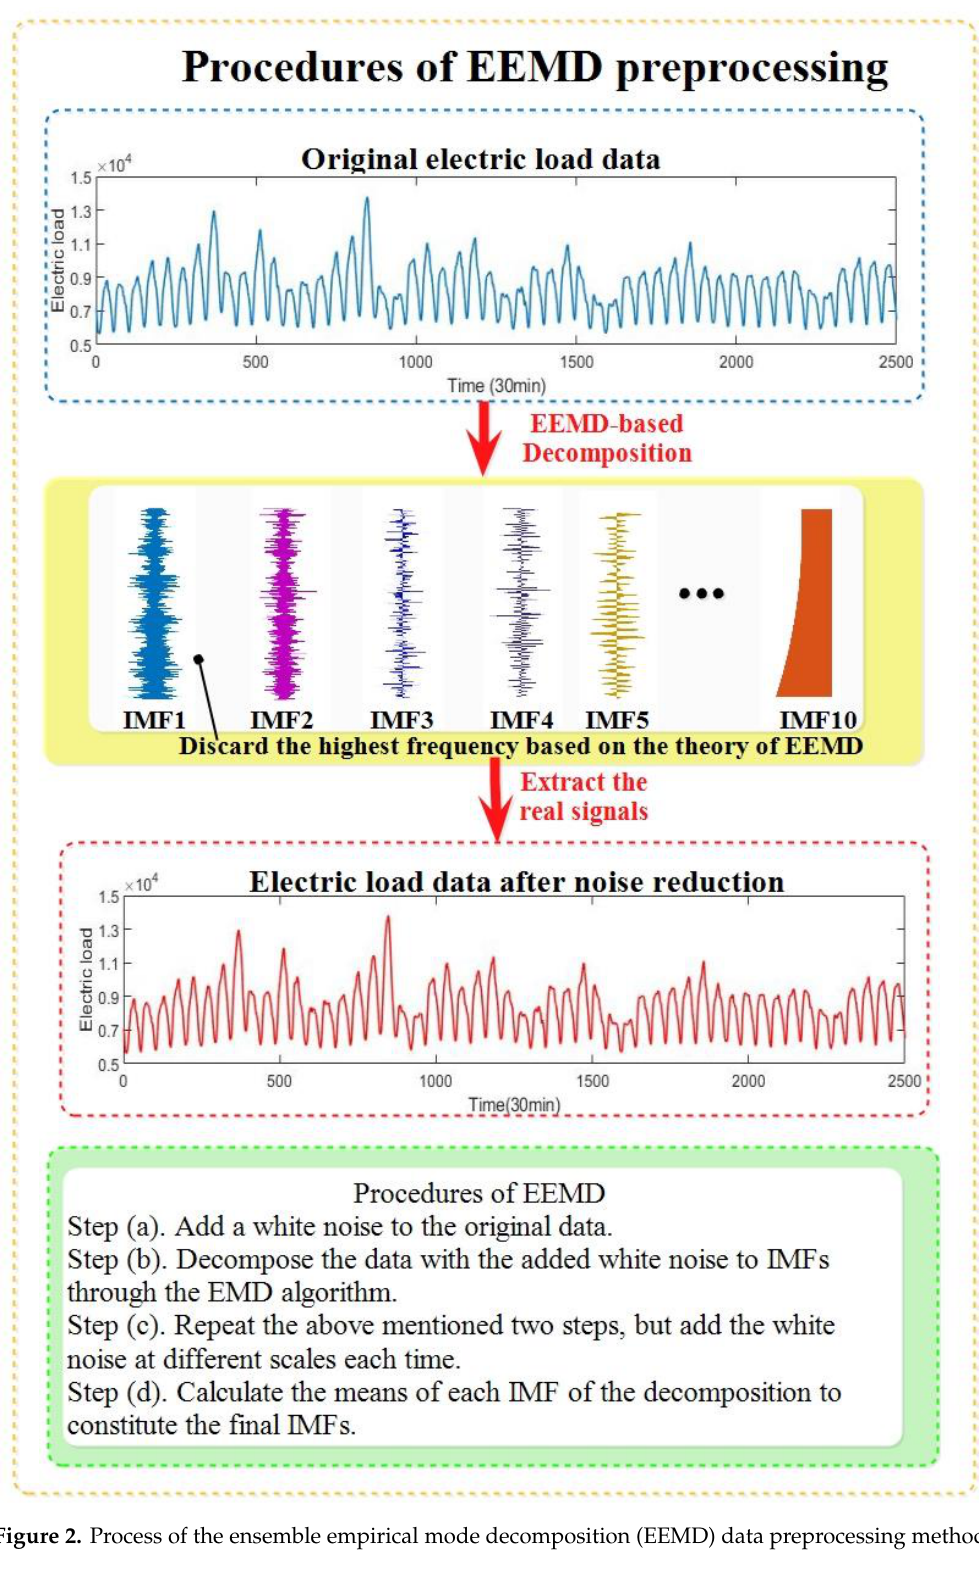
Figure 2. Process of the ensemble empirical mode decomposition (EEMD) data preprocessing method.